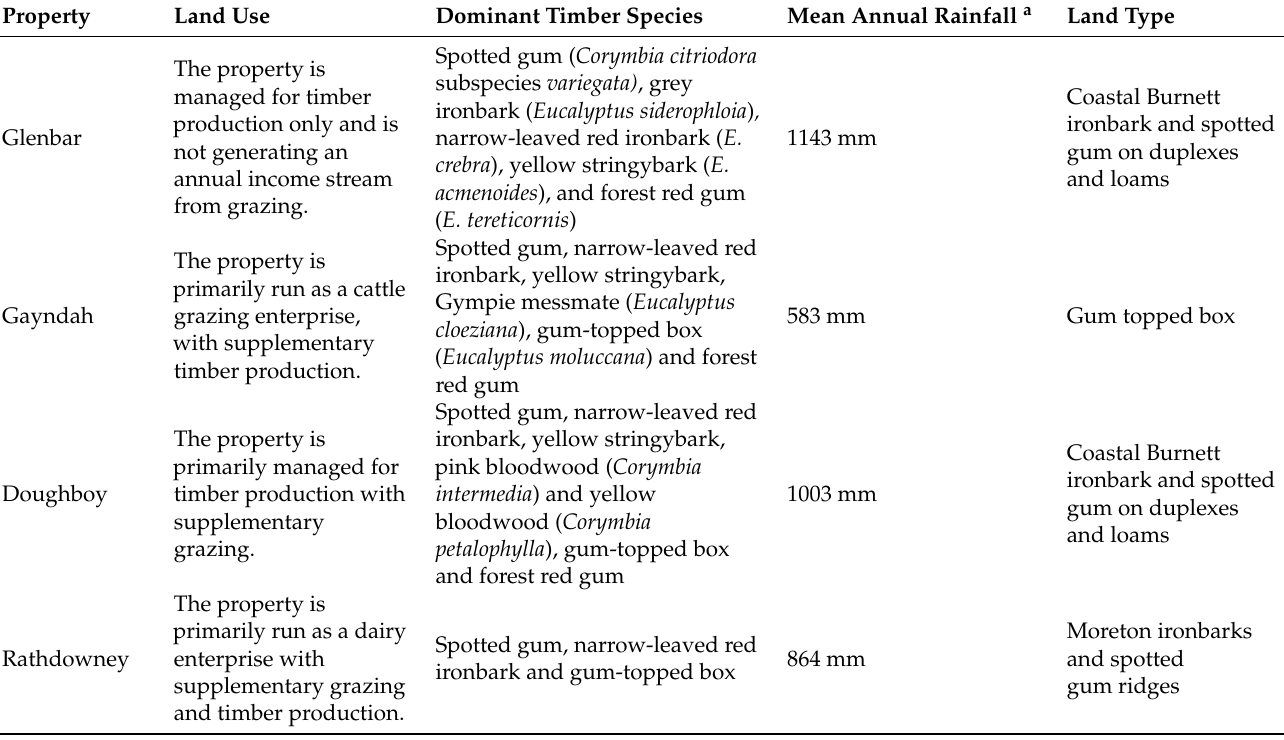
Table 1. Characteristics of the four case study